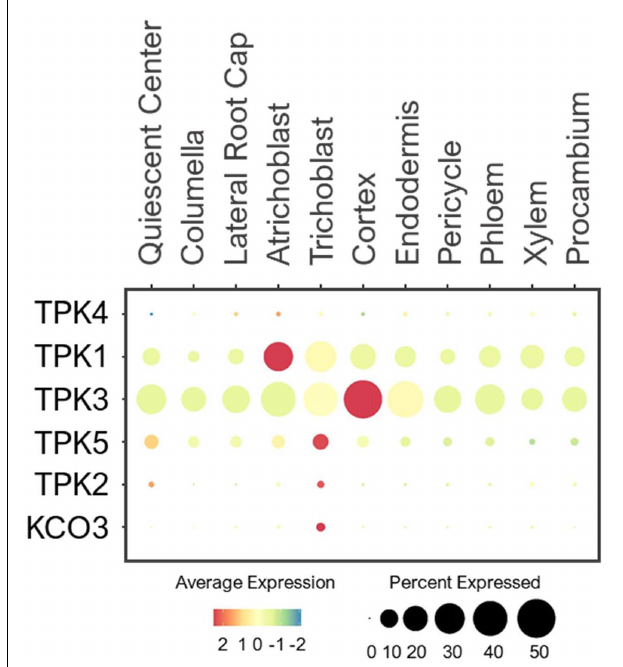
FIGURE 12 | Expression of the TPK channels in Arabidopsis root single cells. In dot plot, the circle size represents the proportion (%) of cells expressing a given gene, and the color of scale bar represents the mean expression (natural log +1